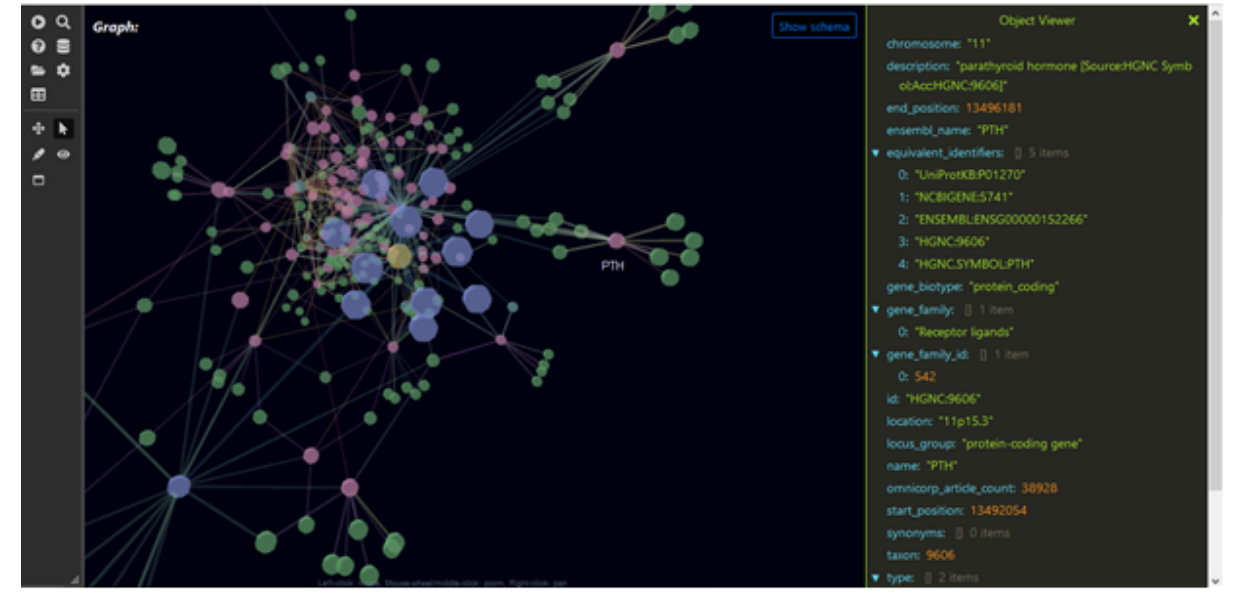
Figure 4. Metadata associated with the gene PTH (parathyroid hormone), which are found in the answer KG for the TranQL query shown in Figure